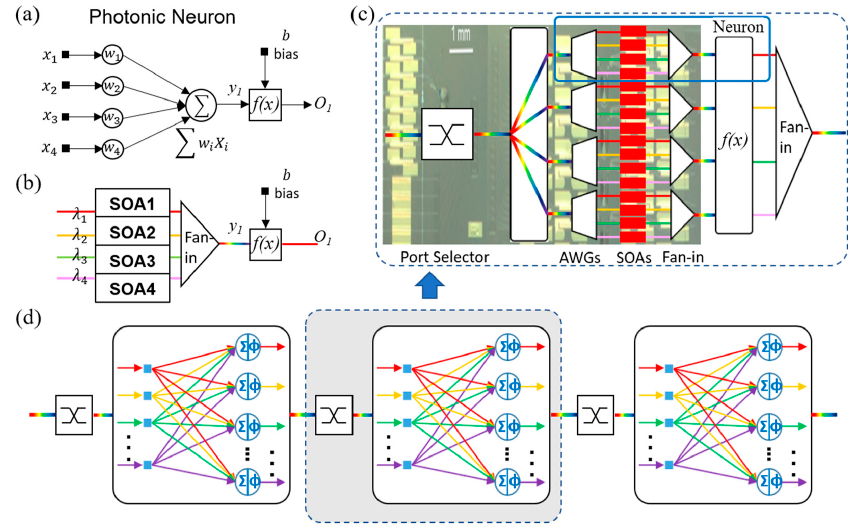
Figure 1. Photonic deep neural network based on the broadcast-and-weight architecture. ( a ) The artificial neuron model. ( b ) The implementation via arrays of semiconductor optical amplifiers (SOAs). ( c ) One full layer of neurons by exploiting one wavelength division multiplexing (WDM) input, with a shaded photonic integrated circuit micrography at the back, to underline that part of the circuitry that is realized on chip. ( d ) Scheme of a three-layer photonic deep neural network. The included port selector may be used to select the desired input